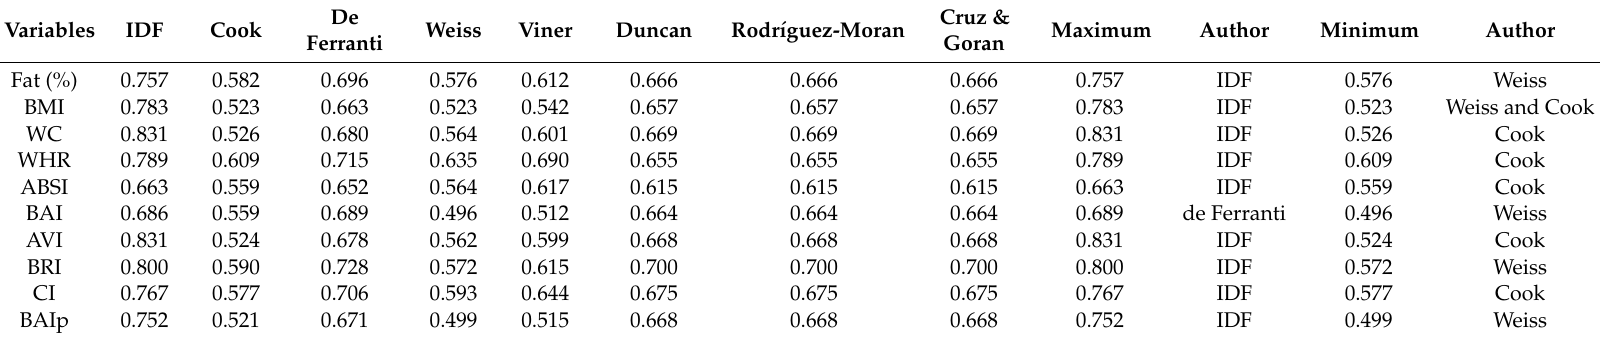
Table 5. Area under the curve (AUC) in receiver-operator curve (ROC) analysis of di ff erent anthropometric indexes for predicting MetS components in boys according to diagnostic criteria.